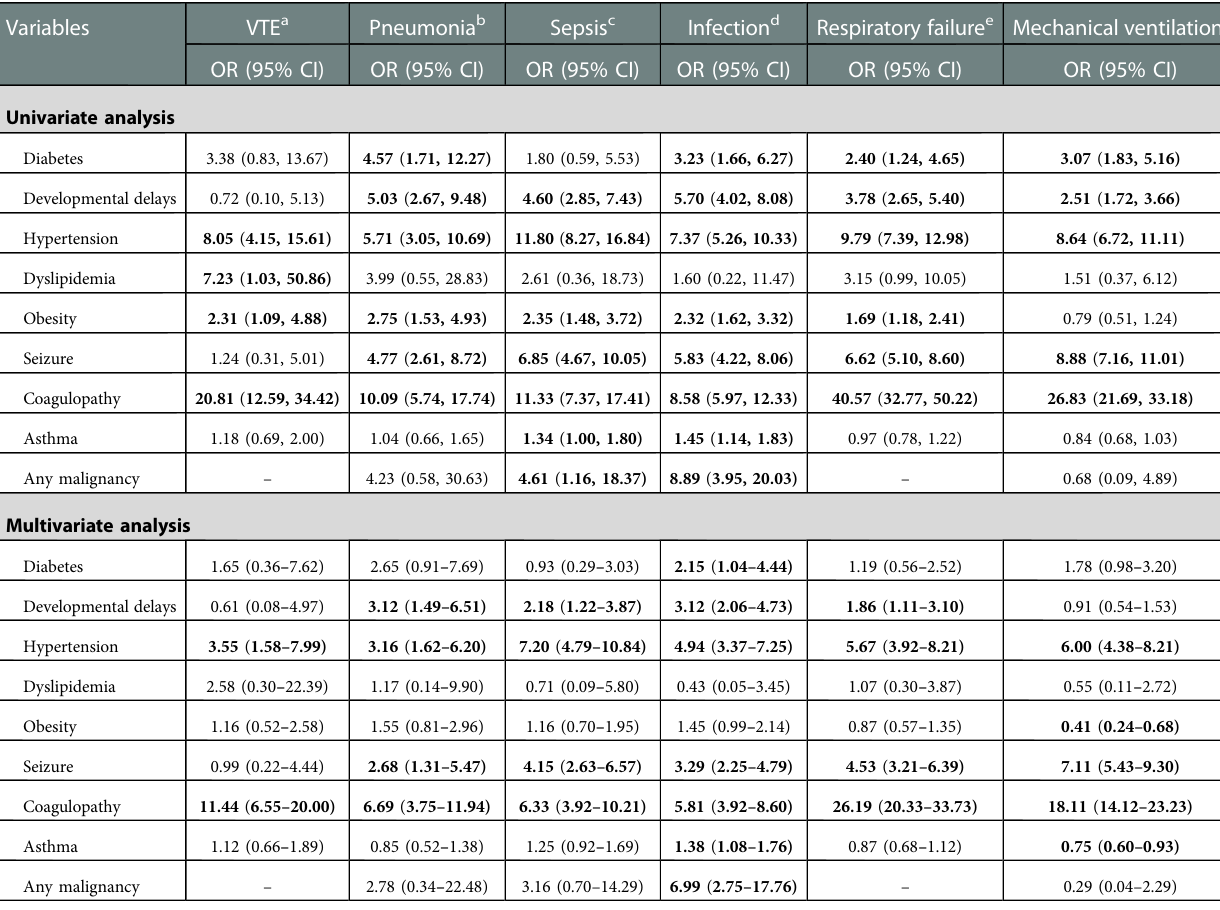
TABLE 5 Univariate analysis and multivariate analysis of associations between comorbidities and morbidities.